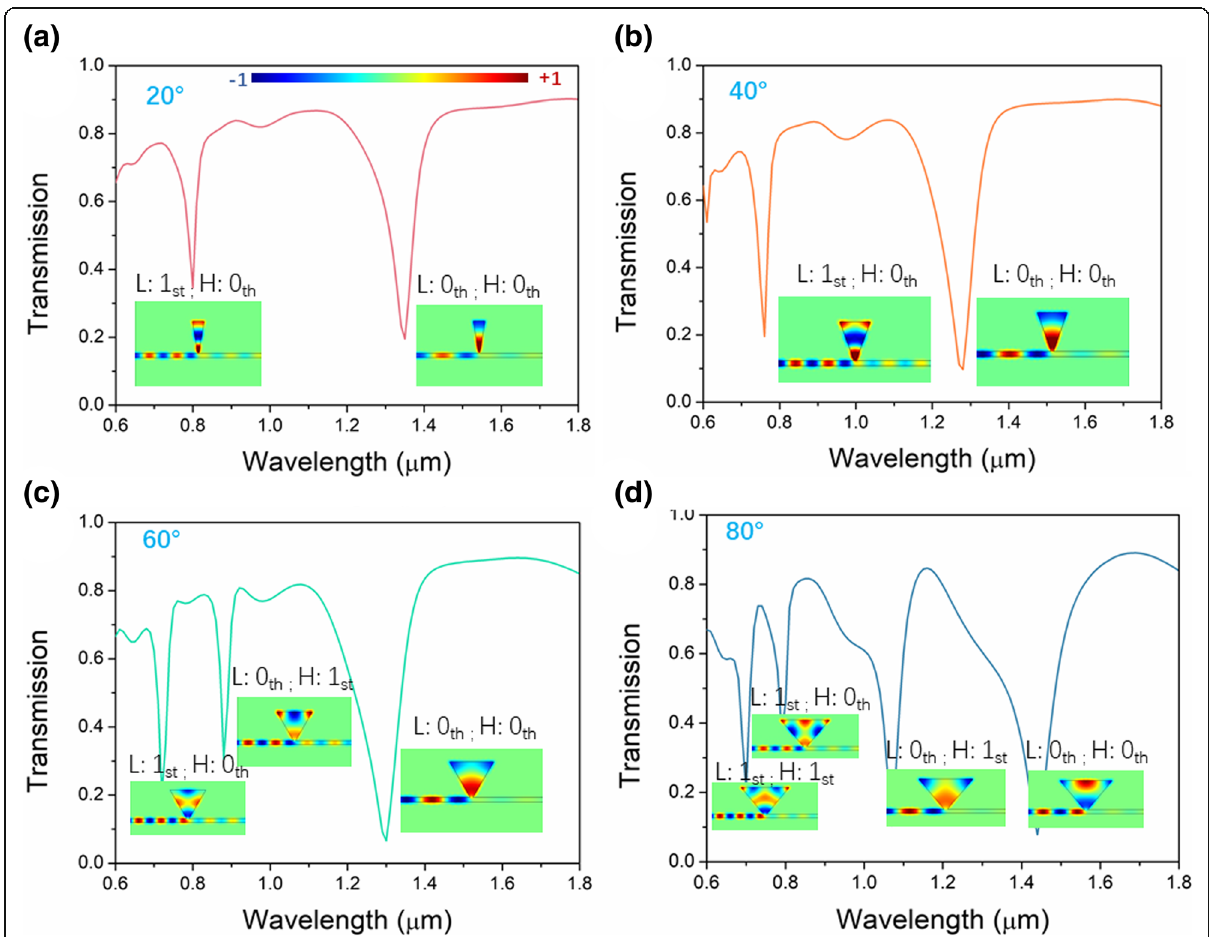
Fig. 2 Transmission spectra of the single triangular resonator for angles of 20° ( a ), 40° ( b ), 60° ( c ), and 80° ( d ). Insets are magnetic field H z corresponding to the resonant